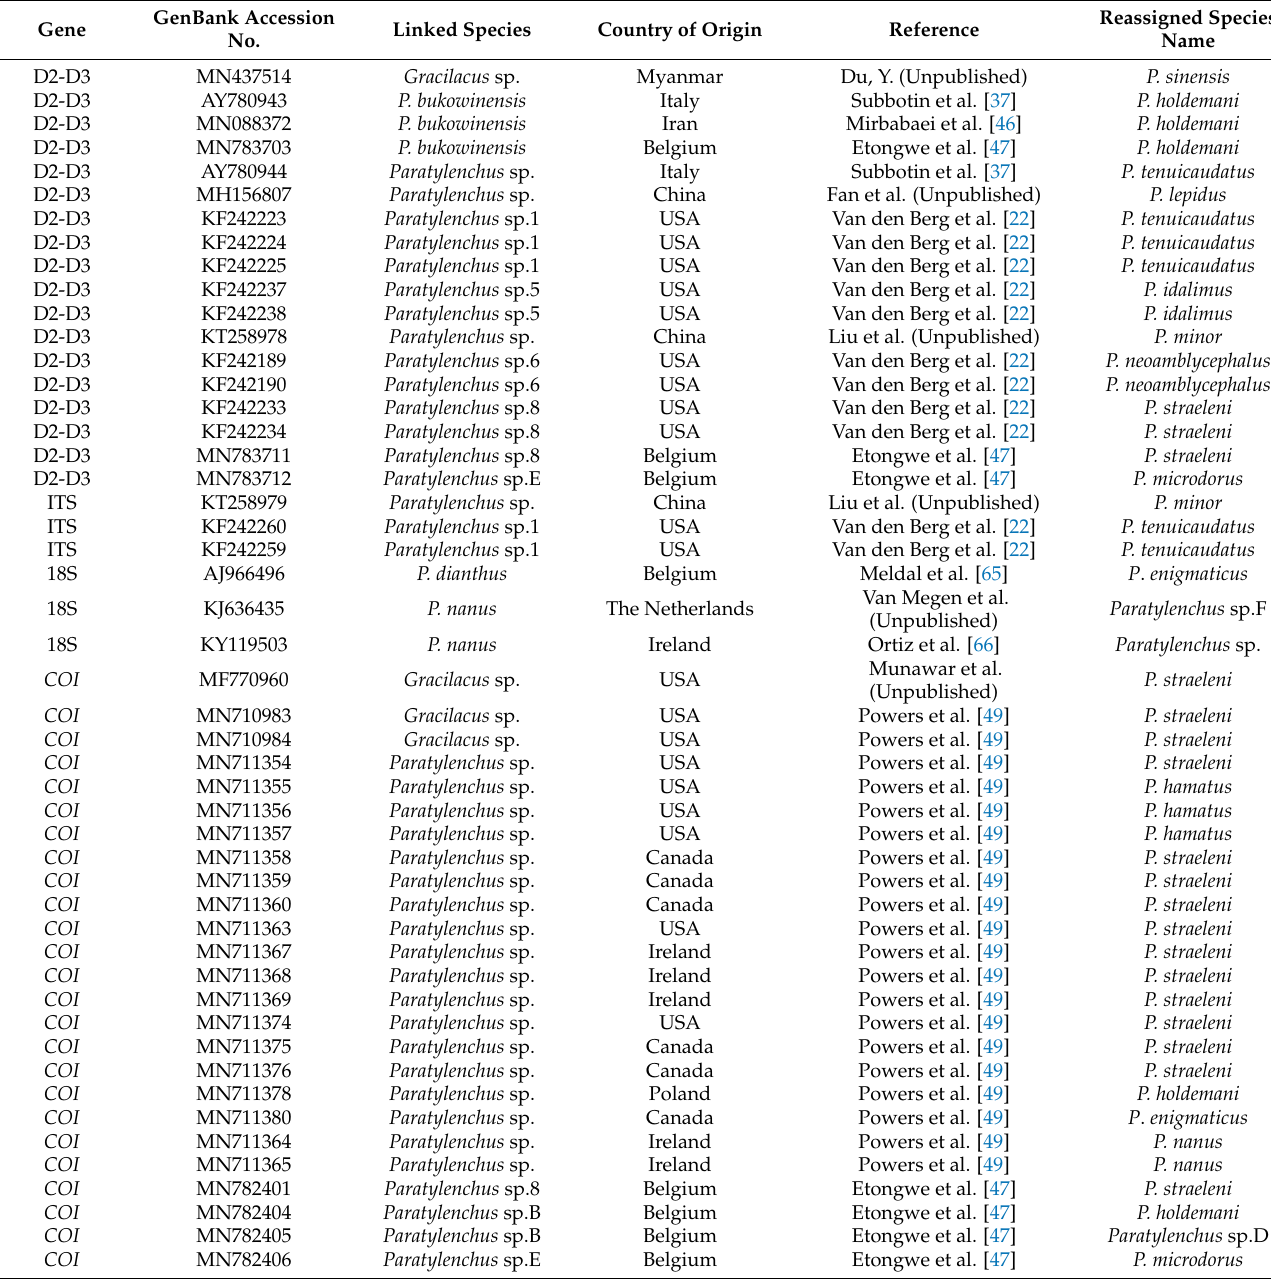
Table 5. List of some existing unidentified or incorrectly classified Paratylenchus sequences on the GenBank reassigned to corrected species. In total, 18 D2-D3 of 28S, 3 ITS, 3 18S rRNA and 25 COI gene sequences have been reassigned. GenBank Accession Gene